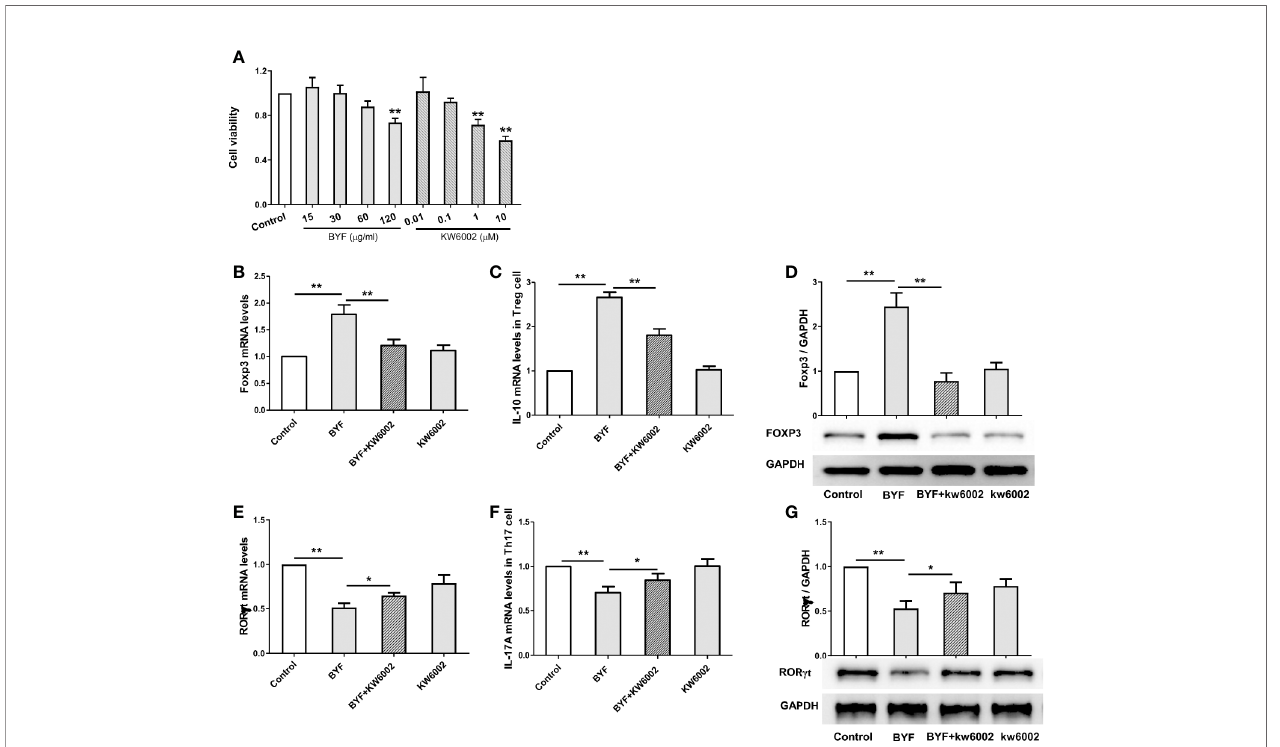
FIGURE 2 | Effect of Bufei Yishen formula (BYF) on Th17 and Treg cell differentiation. Naïve CD4+ T cells were isolated from spleens of mice, and treated with Th17 differentiation conditions or Treg differentiation conditions in the presence or absence of BYF (60 m g/ml) or KW6002 (0.1 m M) for 3 days. (A) the effect of BYF and KW6002 on cell viability of Naïve CD4+ T cells. (B) The mRNA levels for Foxp3. (C) The mRNA levels IL-10. (D) The protein level of Foxp3. (E) ROR g t mRNA; (F) IL- 17 mRNA; (G) ROR g t protein. *P < 0.05, **P <